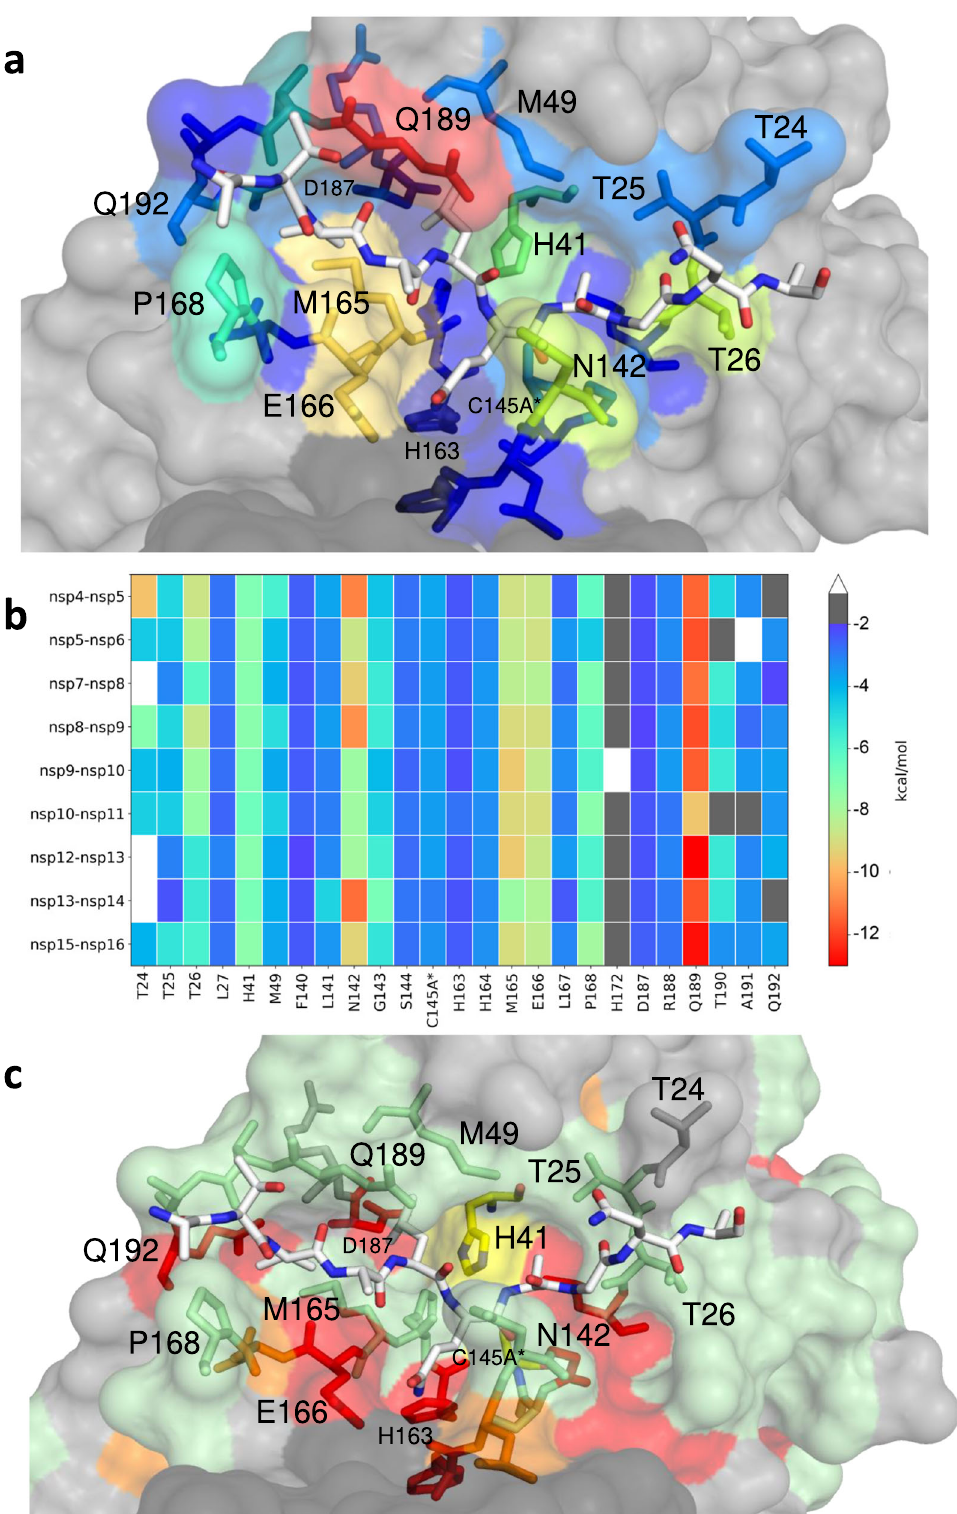
Fig. 3 Extent of substrate interactions and conservation of M pro surface residues. a Close-up view of the nsp9-nsp10 substrate bound to M pro active site in the cocrystal structure where the substrate peptide is depicted as white sticks and the protease is in surface representation. The protease residues are colored according to the extent of van der Waals interactions with the substrate, with warmer colors indicating more interaction. b Conservation of substrate-protease van der Waals interactions among the 9 cocrystal structures determined. Heat map coloring by extent of van der Waals contact by residue. c Amino acid sequence conservation of M pro between 7 (Supplementary Fig. 4) coronaviral species depicted on the structure where surface residues conserved in all 7 (red), 5-6 (orange), 3-4 (green) and less than 3 (highly variable; gray) sequences are indicated by color.